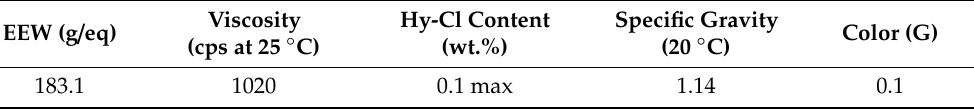
Table 1. Properties of bisphenol A-type EP.